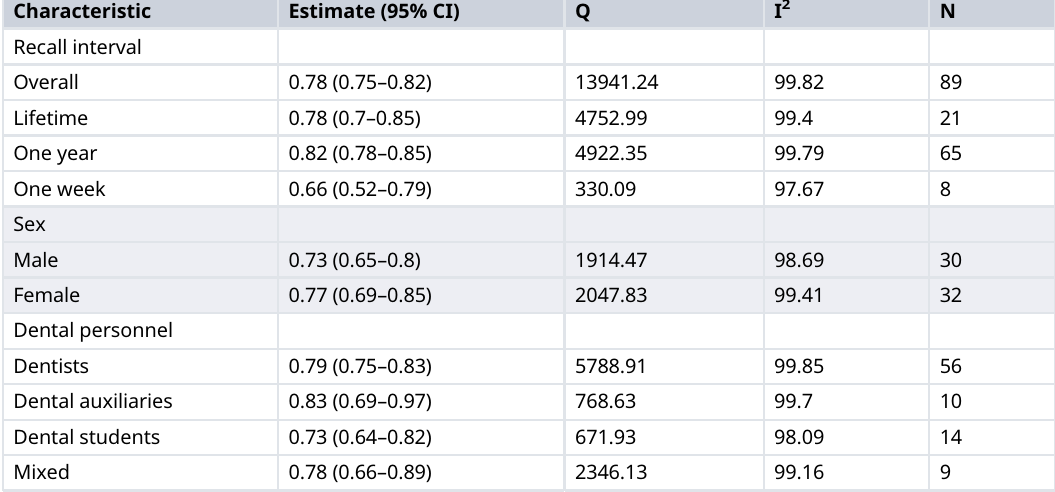
Table 2. Sub-group analysis of the pooled estimates of overall musculoskeletal disorders.